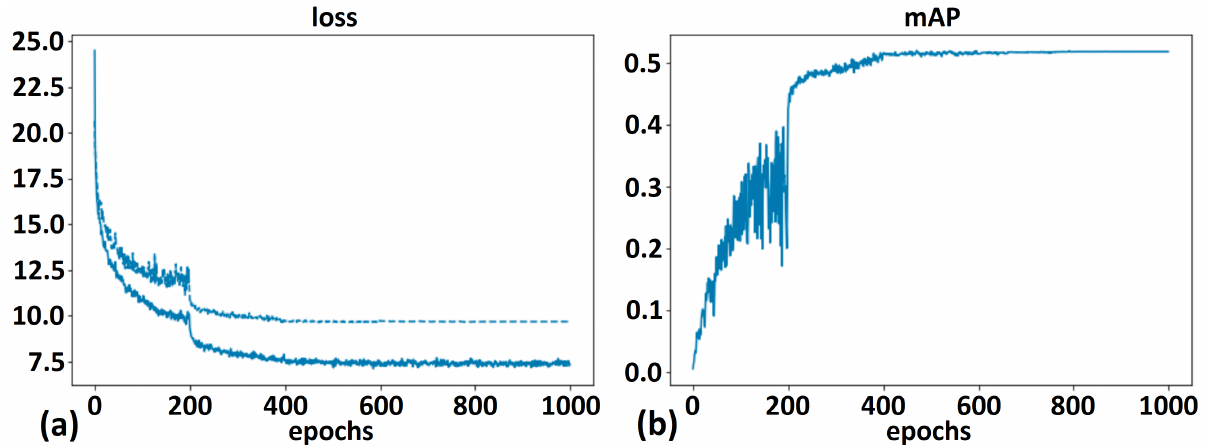
Figure 5. DETR results: ( a ) loss function obtained for the training set (solid line) and the validation set (dashed line) during 1000 epochs, for two categories (4th experiment); ( b ) mAP scores obtained for the validation set.